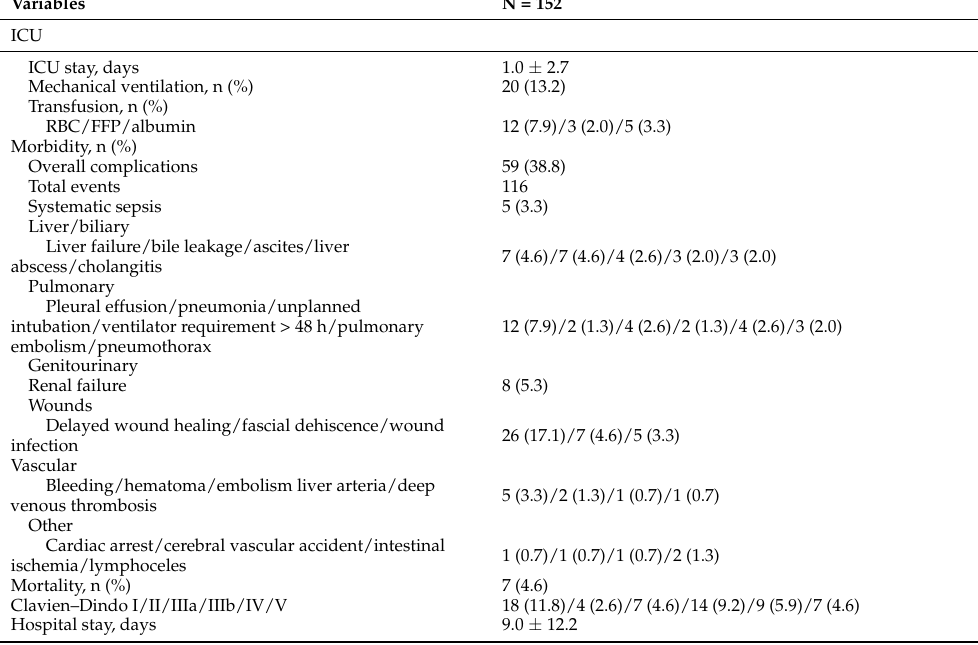
Table 2. Summary of the postoperative outcome in 152 patients after liver resection.